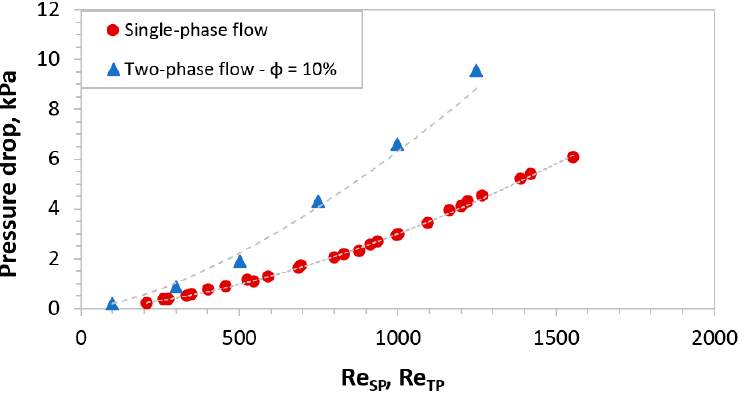
Figure 11. Pressure drop for single phase and two-phase flow versus Reynolds number.